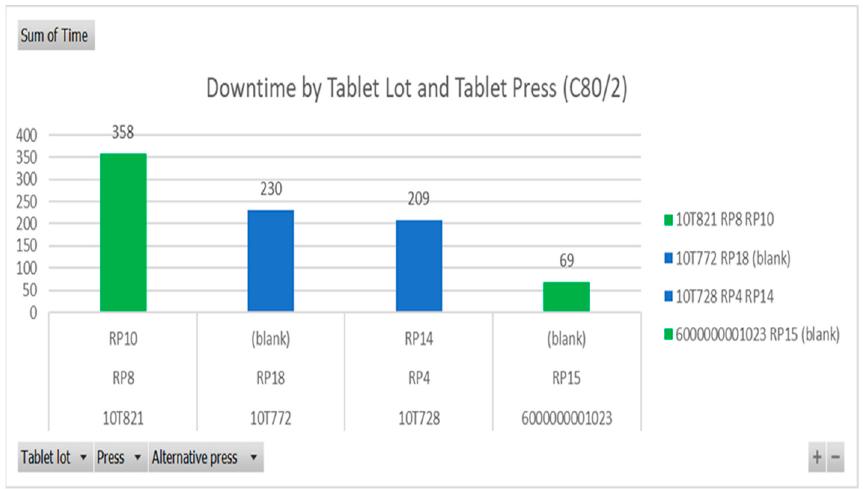
Figure 12. Downtime by Tablet Type demonstrated that product type 10C821 had the highest downtime.